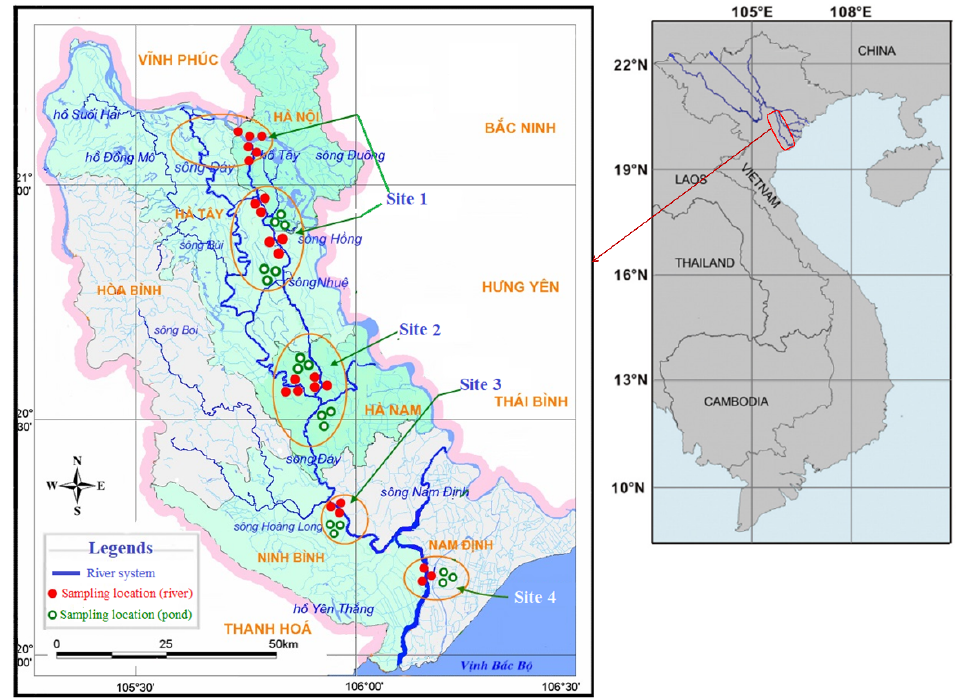
Figure 1. A map of the Nhue-Day River basin with sampling locations at four study sites. Closed red dots indicate sampling locations in rivers, while open green dots illustrate locations in aquacul- ture ponds.